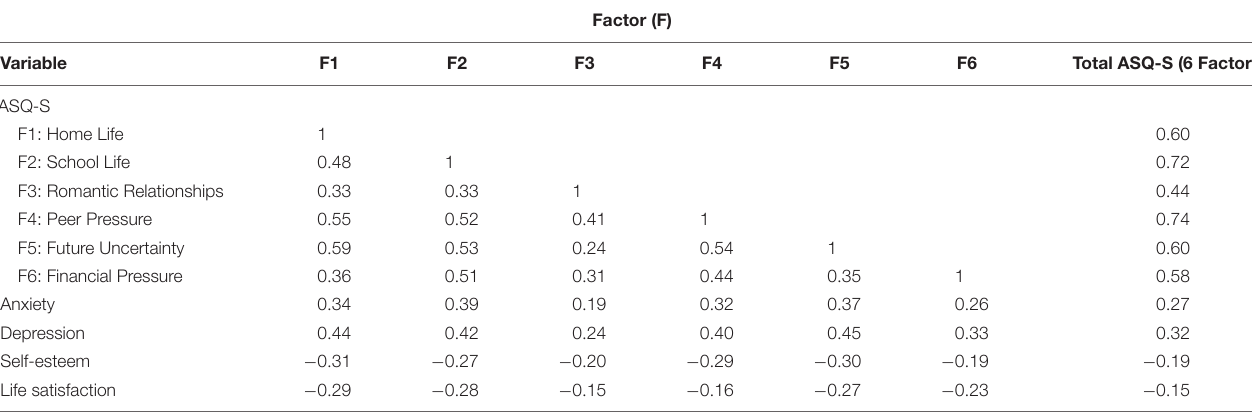
TABLE 6 | Pearson’s correlations between the adolescent stress questionnaire (ASQ-S) scores (6-factors solution) and anxiety, depression, self-esteem and life satisfaction measures.